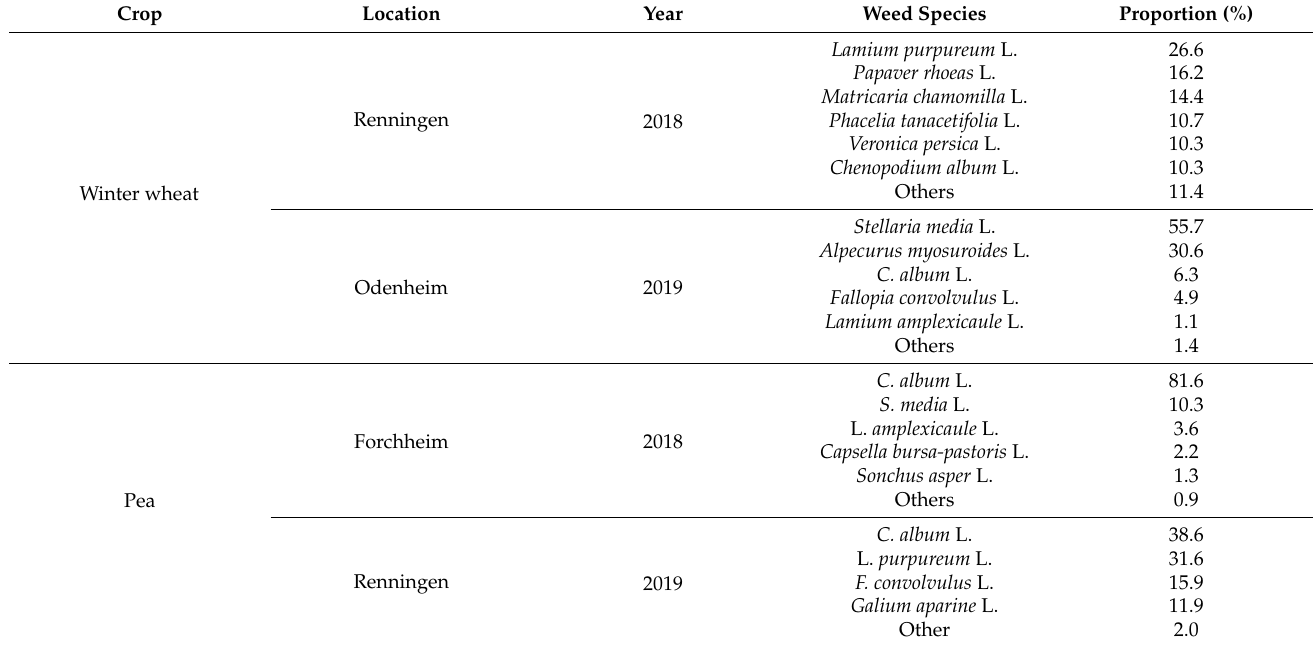
Table 6. Weed composition at the three locations Forchheim, Renningen, and Odenheim in the years 2018, 2019, and 2020. Crop Location Year Weed Species Proportion (%)